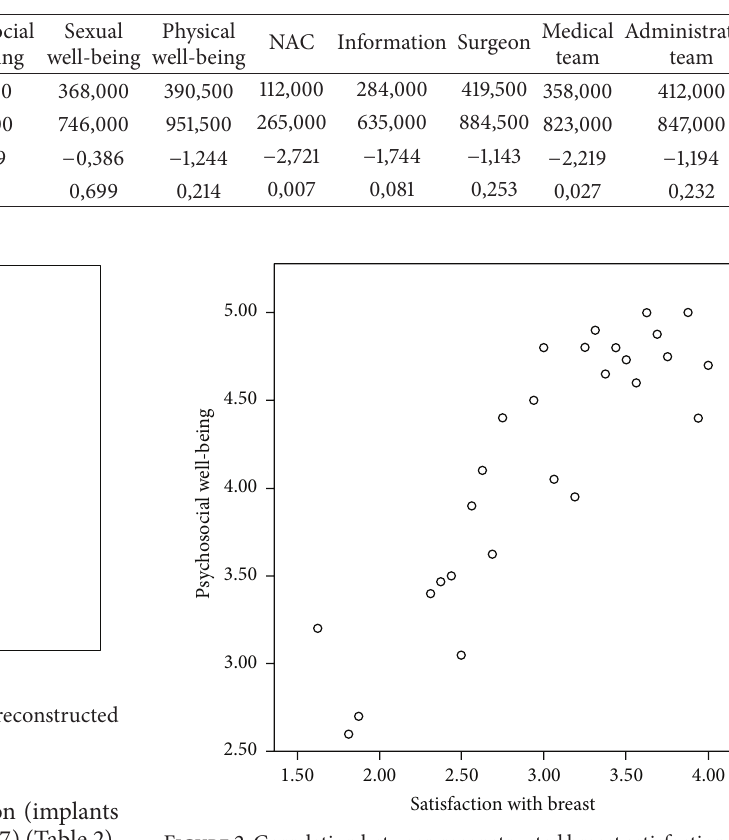
Table 2: The statistical significance of differences between the two groups. The Mann-Whitney and Wilcoxon nonparametric tests allow comparing samples without a normal distribution.